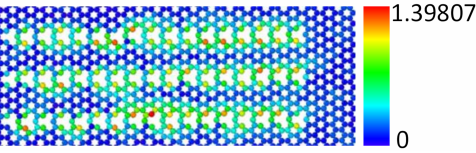
Figure 7. Displacement cloud of graphene nanoribbon with vacancy concentration of 5% at a relaxation time of 10 ps.